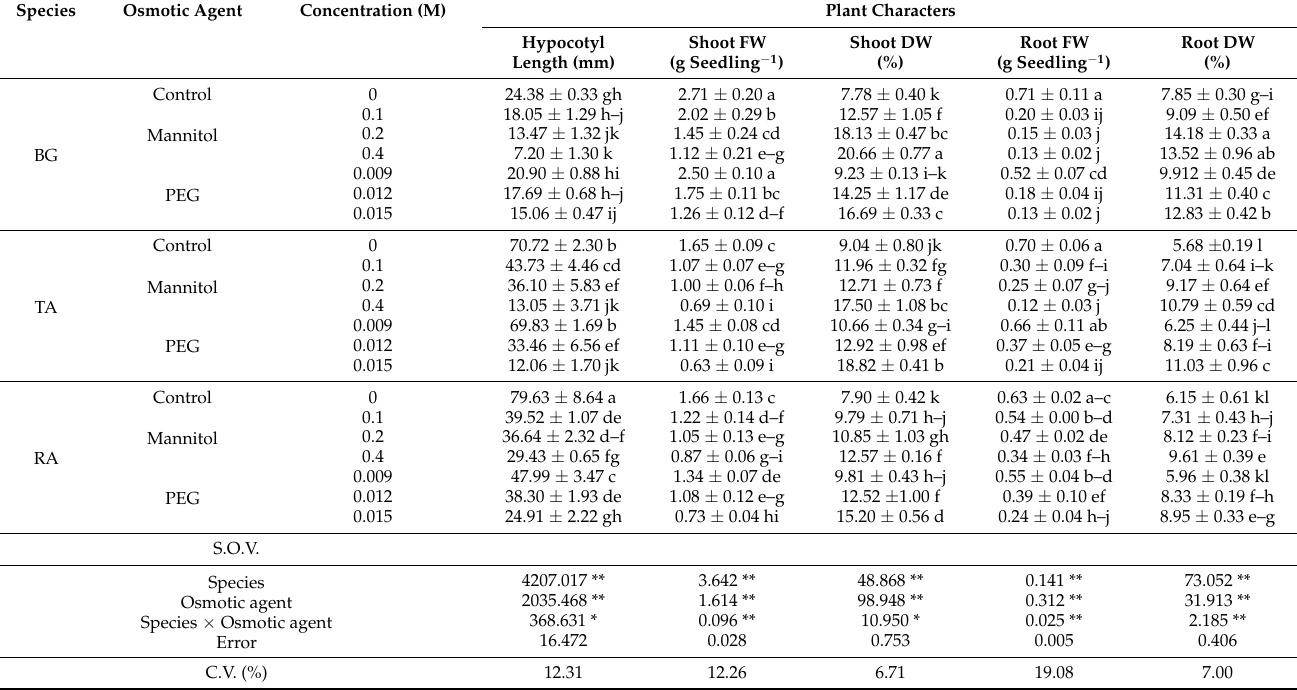
Table 1. Effect of osmotic stress induced by mannitol and PEG on morphological traits of Cucurbita sp. under in vitro culture